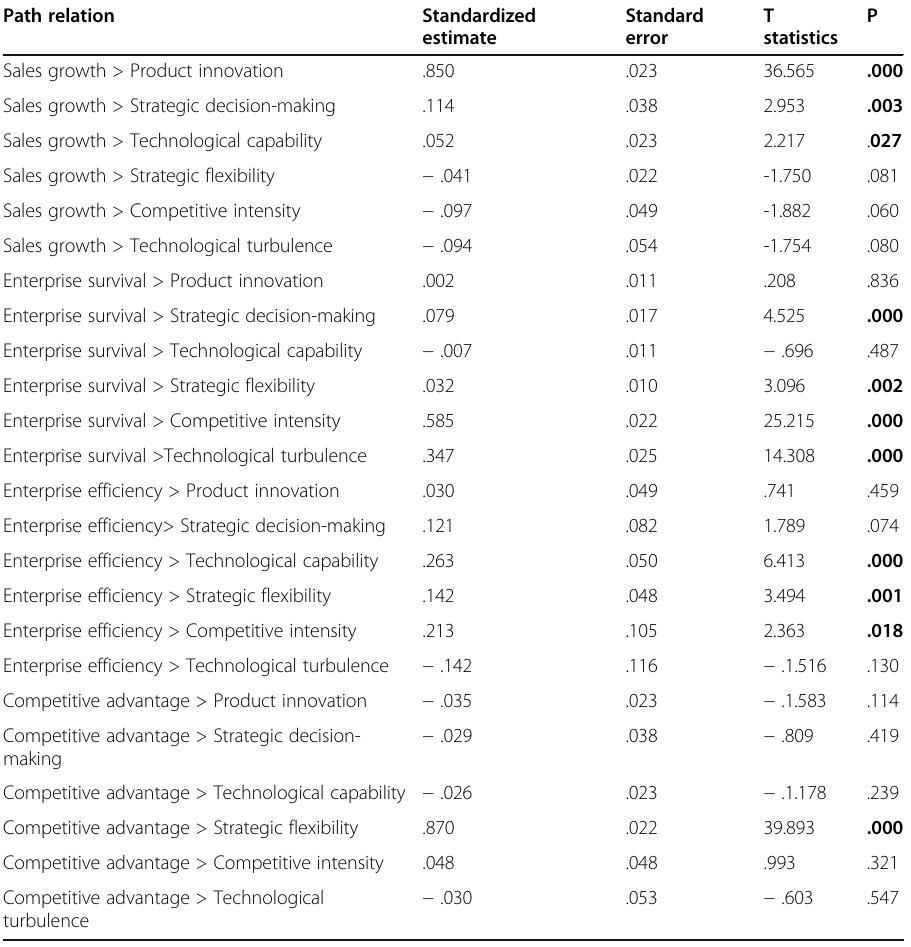
Table 2 Path coefficient between the latent variables and observed variables Path relation Standardized